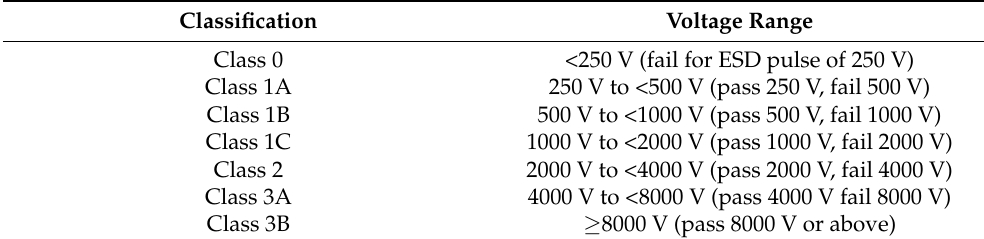
Table 2. ESD immunity classification for the human body model